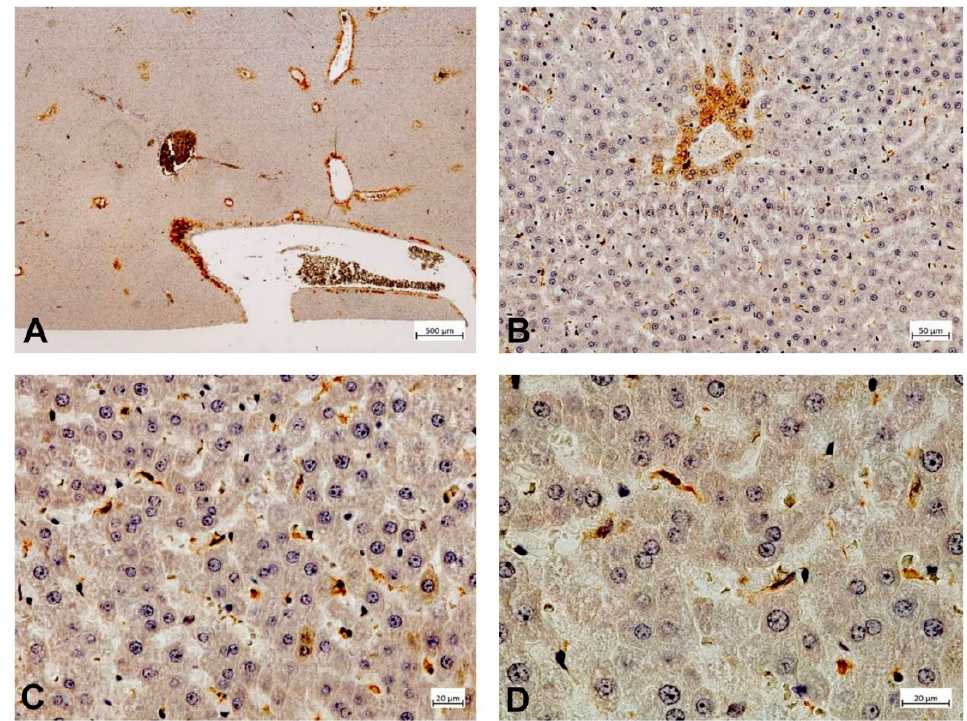
Figure 2. Phosphodiesterase-5 (PDE-5) expression in healthy rat liver tissue. Hepatocytes around the terminal hepatic venules ( A , B ) and adjacent to medium-sized intercalated veins ( A ) display strong cytoplasmic PDE-5 immunoreactivity. PDE-5 expression by sinusoidal lining cells is most prominent in zone 3 ( C , D ).